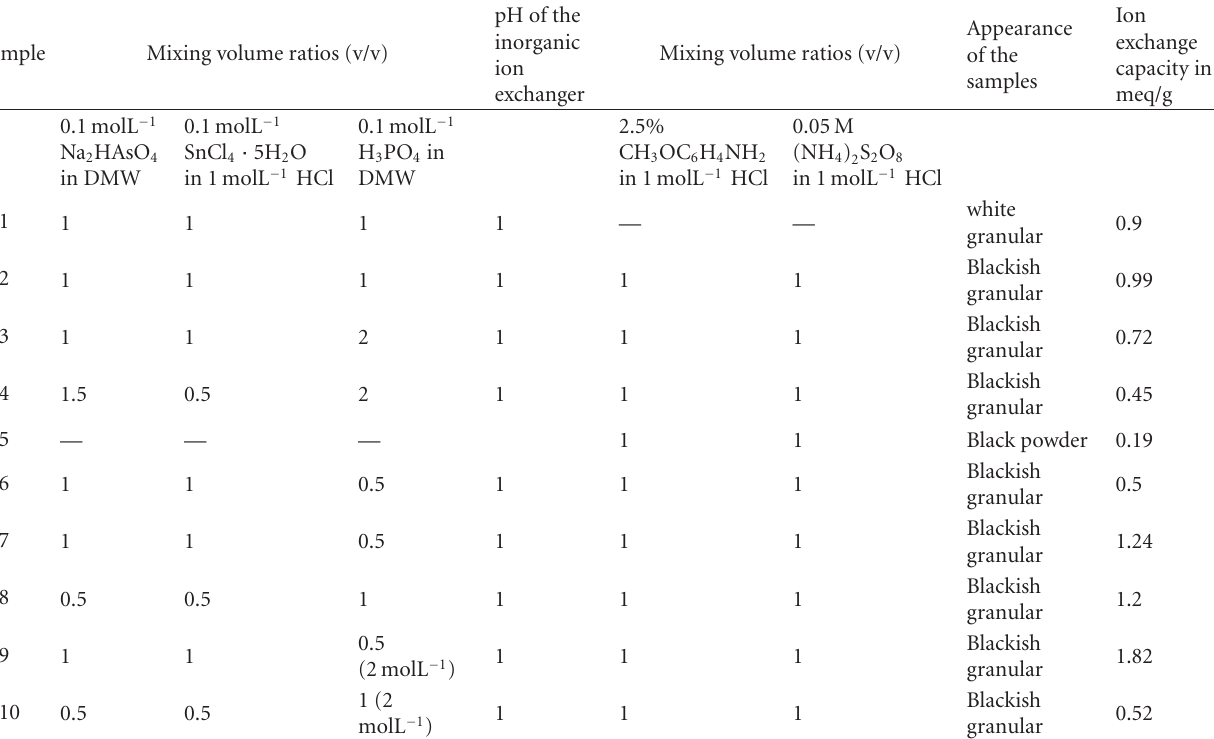
Table 2: Conditions of preparation and the ion exchange capacity of poly-o-anisidine Sn(IV) arsenophosphate composite cation exchanger.